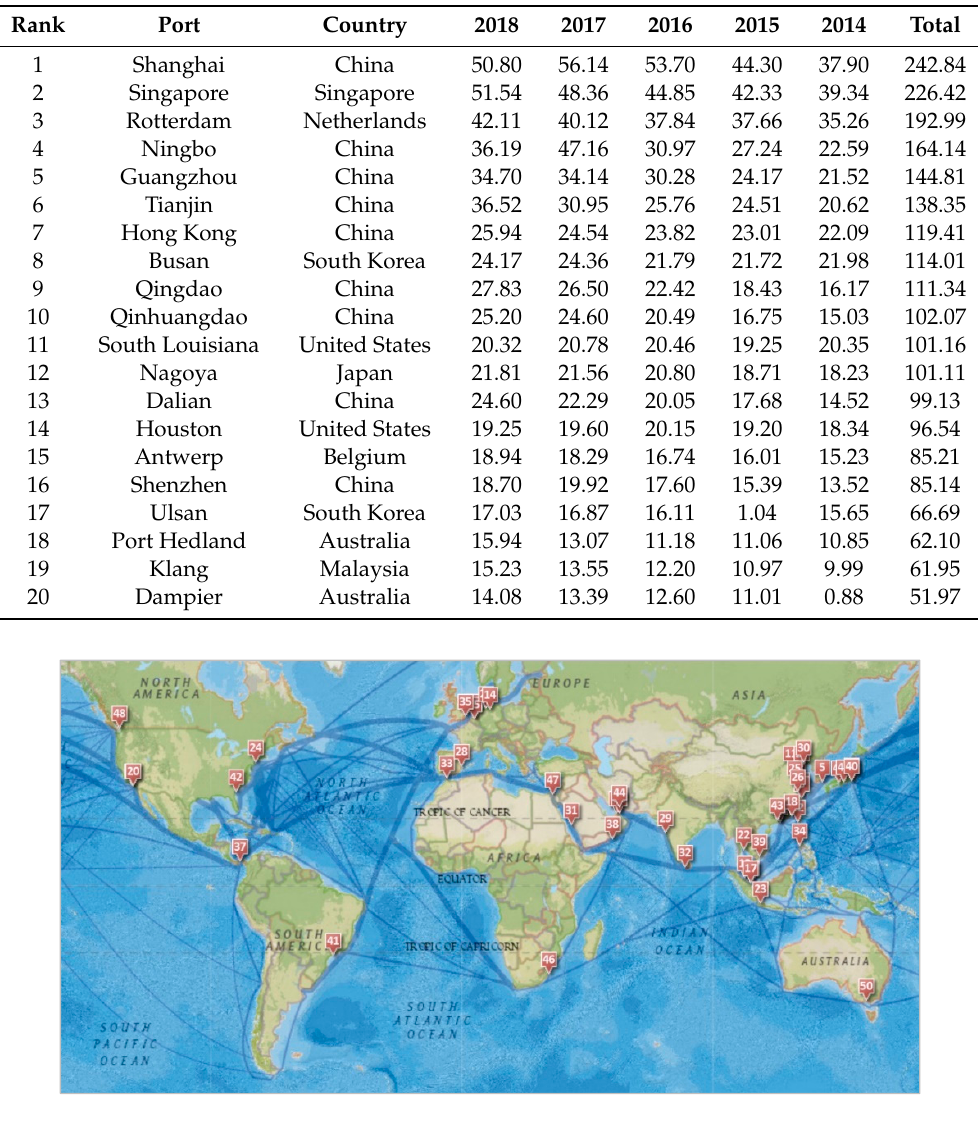
Figure 6. Top 50 international ports by TEU, 2017.